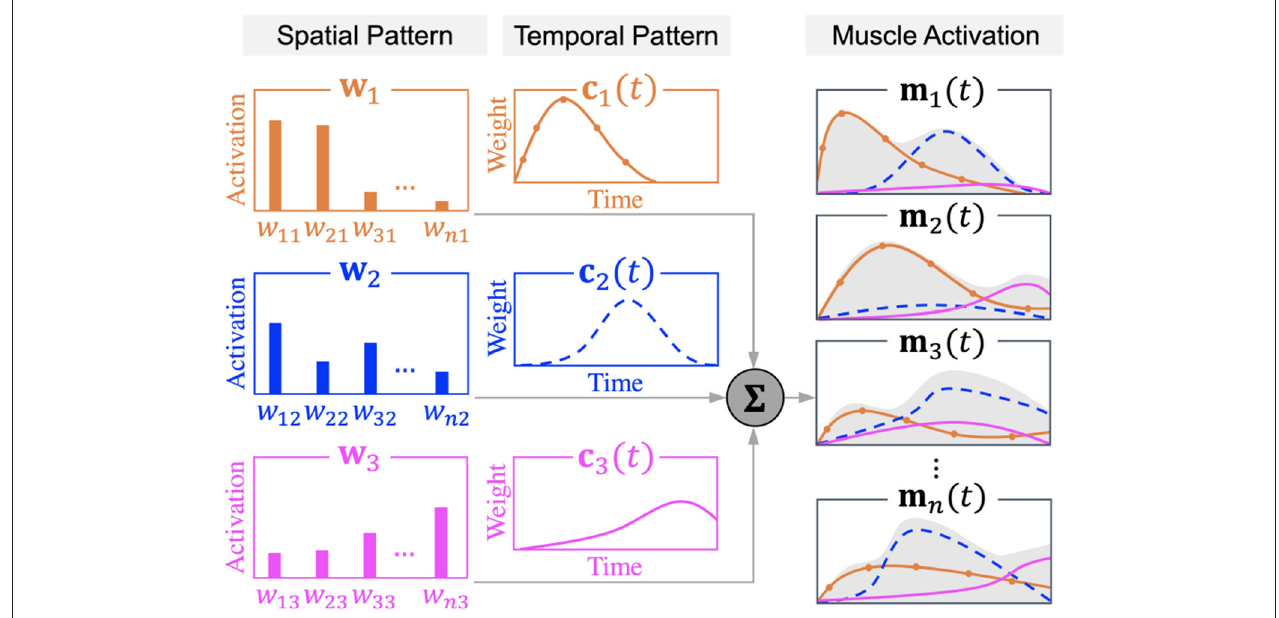
FIGURE 3 | Muscle synergy